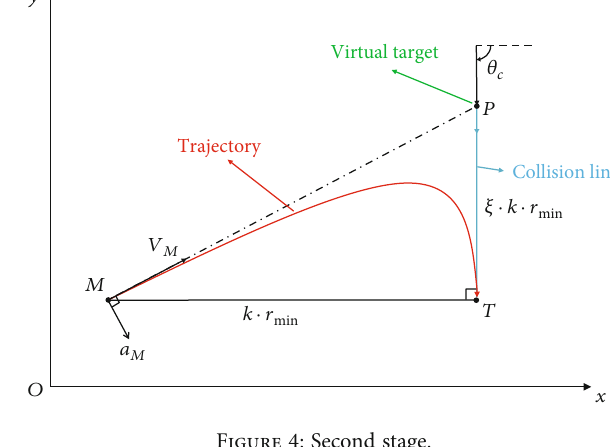
Figure 4: Second stage.